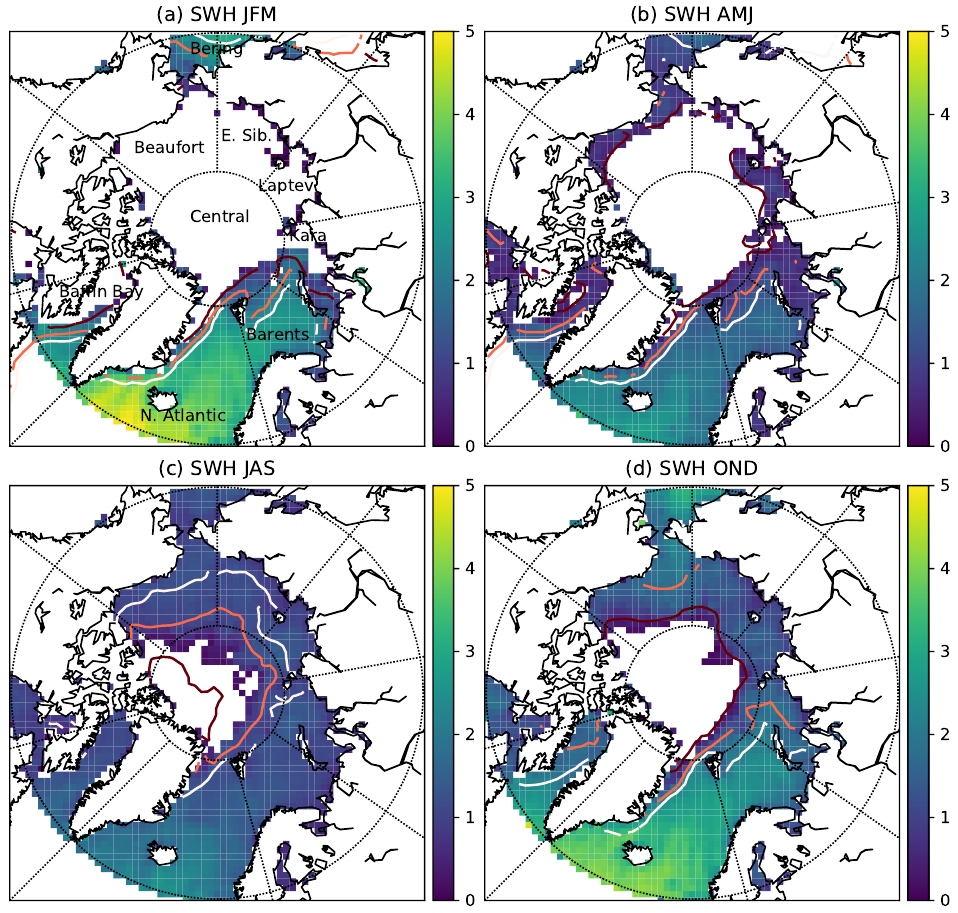
Figure 9. Climatological maps of retirieved SWH (m) for ( a ) Jan. Feb. Mar., ( b ) Apr. May. Jun., ( c ) Jul. Aug. Sep., ( d ) Oct. Nov. Dec. for the years 2011–2019. Plot ( a ) indicates the regions used in Figure 10. Overlaid on each plots are the average contours of 15% 50% and 85% sea NSIDC ice concentration for that quarter. Note that the Beaufort region also encompasses the Chukchi and Bering